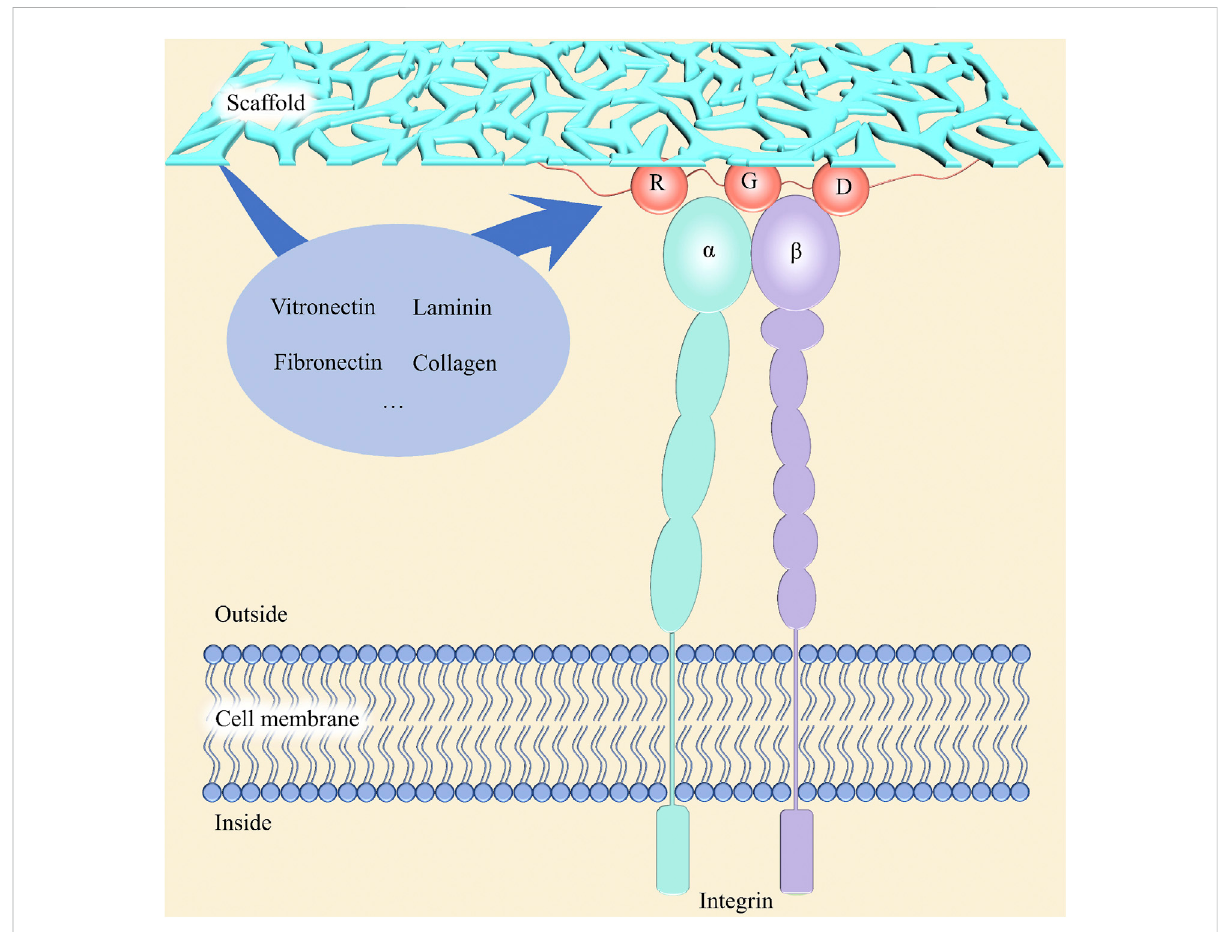
FIGURE 6 Schematic diagram for the mechanism of cell adhesion on scaffolds. Integrin, located on the cell membrane, is consisted of an a -subunit and a ß -subunit,whichmediatescelladhesiontotheextracellularmatrix via bindingtotheRGDsequencesinsomeproteins,suchascollagen, fi bronectin, vitronectin, and